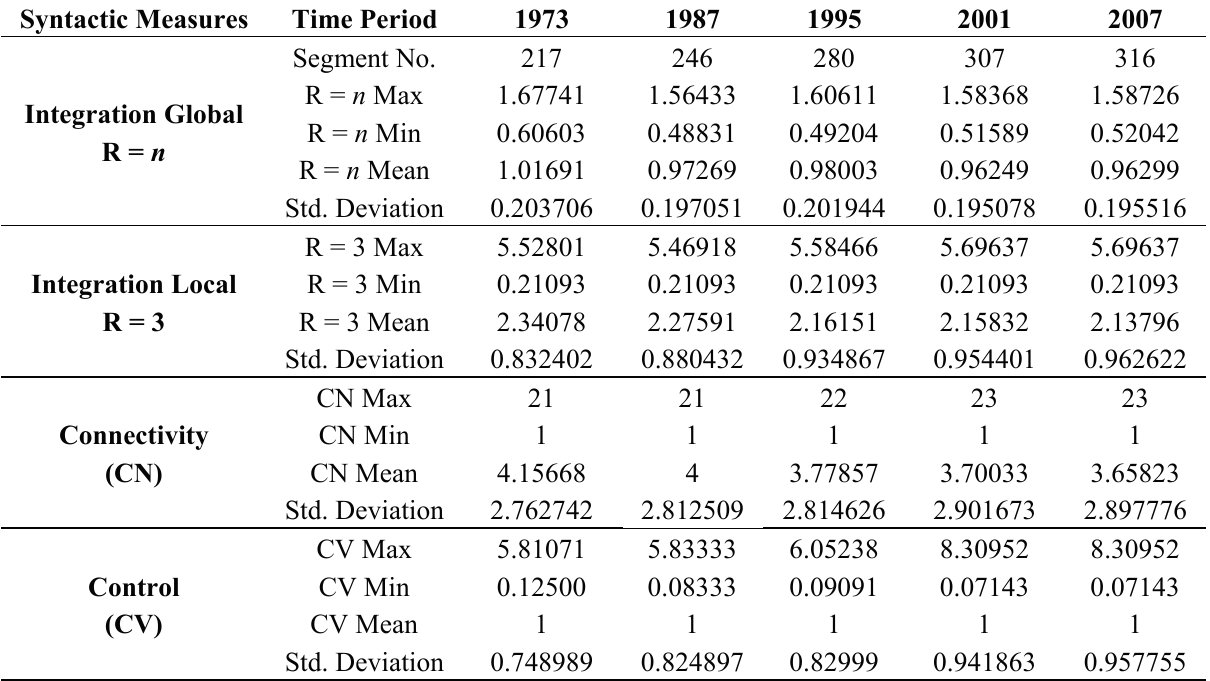
Table 2. Syntactic measures of ward 19 (Gulshan) in different time periods.